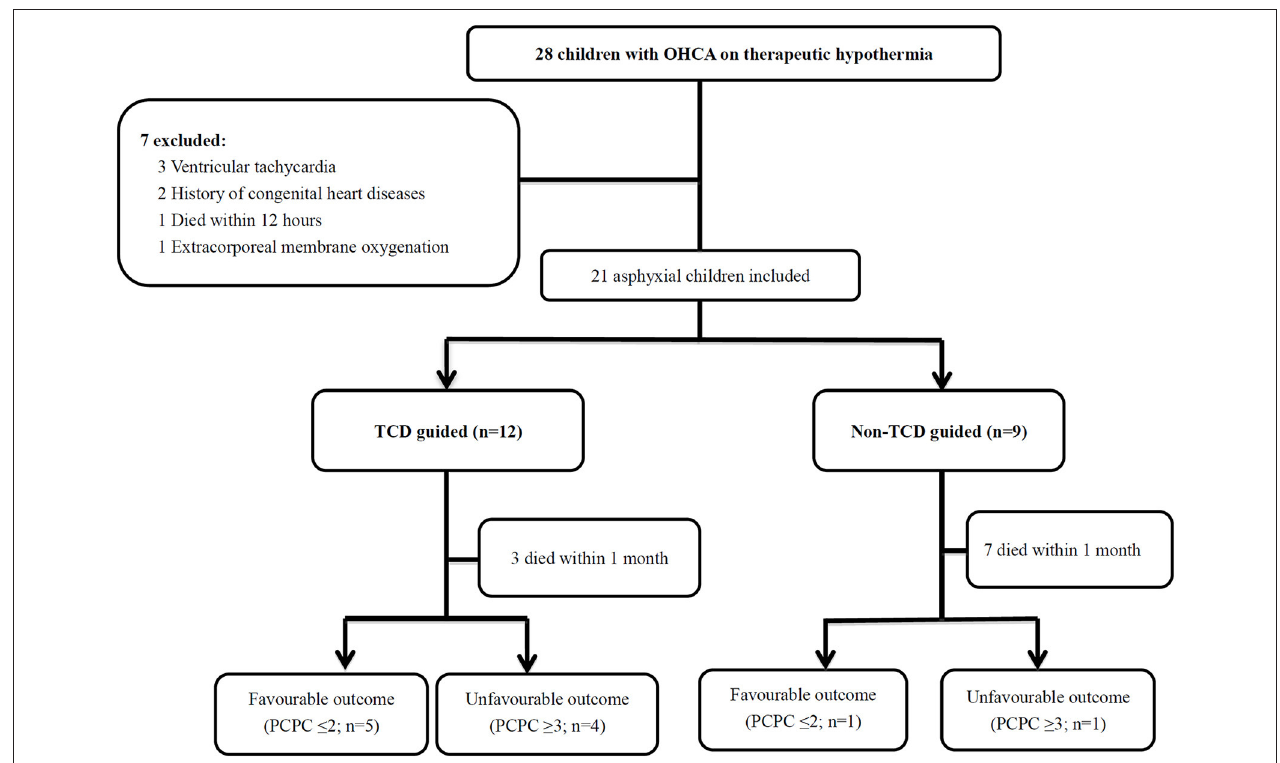
FIGURE 1 | Twenty-eight patients with OHCA with therapeutic hypothermia were identified. A total of 7 children were excluded, and 21 asphyxial OHCA comatose patients were enrolled, including 12 patients who received the TCD guided cerebral resuscitation protocol and 9 patients without the TCD guided cerebral resuscitation protocol. The patients with 6-month neurological outcomes included those who died during the follow-up period. The survival rate was significantly higher ( p = 0.03) in the TCD guided group (9/12, 75%) compared with the non-TCD guided group (2/9, 22.2%). OHCA, out-of-hospital cardiac arrest; PCPC, pediatric cerebral performance category; TCD, Transcranial Doppler